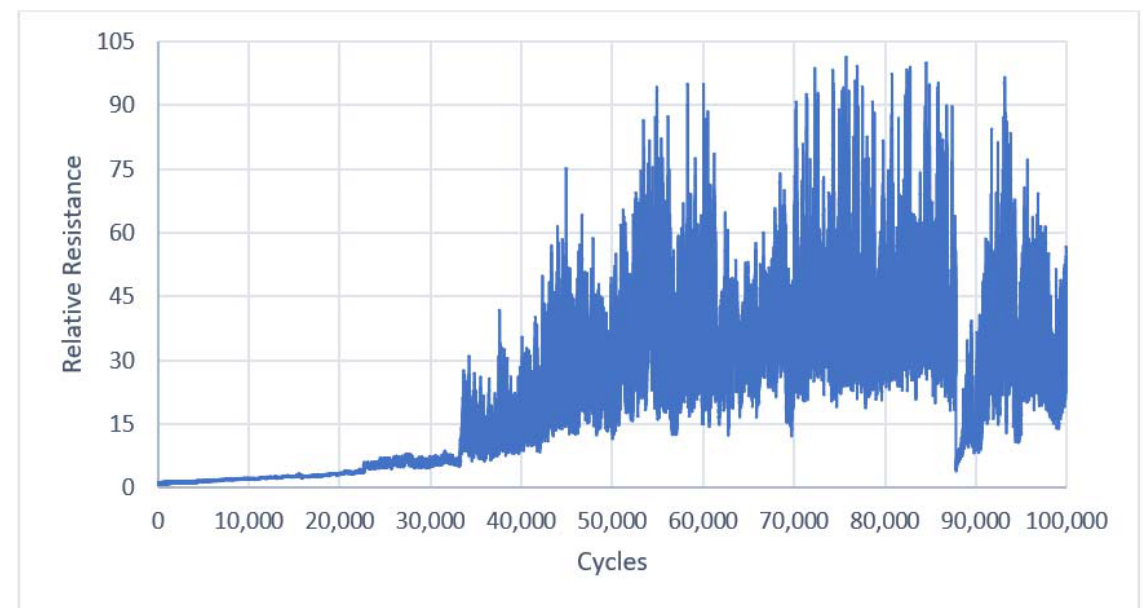
Figure 8. Average relative resistance of the electroconductive strips versus bending cycles for a Ponge/Soliani electro- conductive fabric.